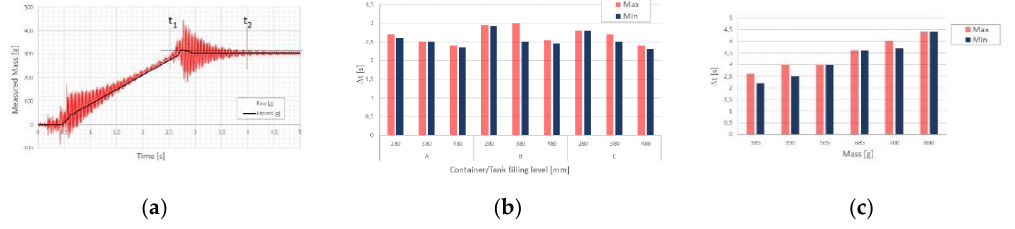
Figure 8. ( a ) Estimation of ∆ t time ( t 2 − t 1 ) ( b ) Influence of the container geometry and of the tank filling level on time ∆ t ; ( c ) Influence of the delivered mass on time ∆ t .